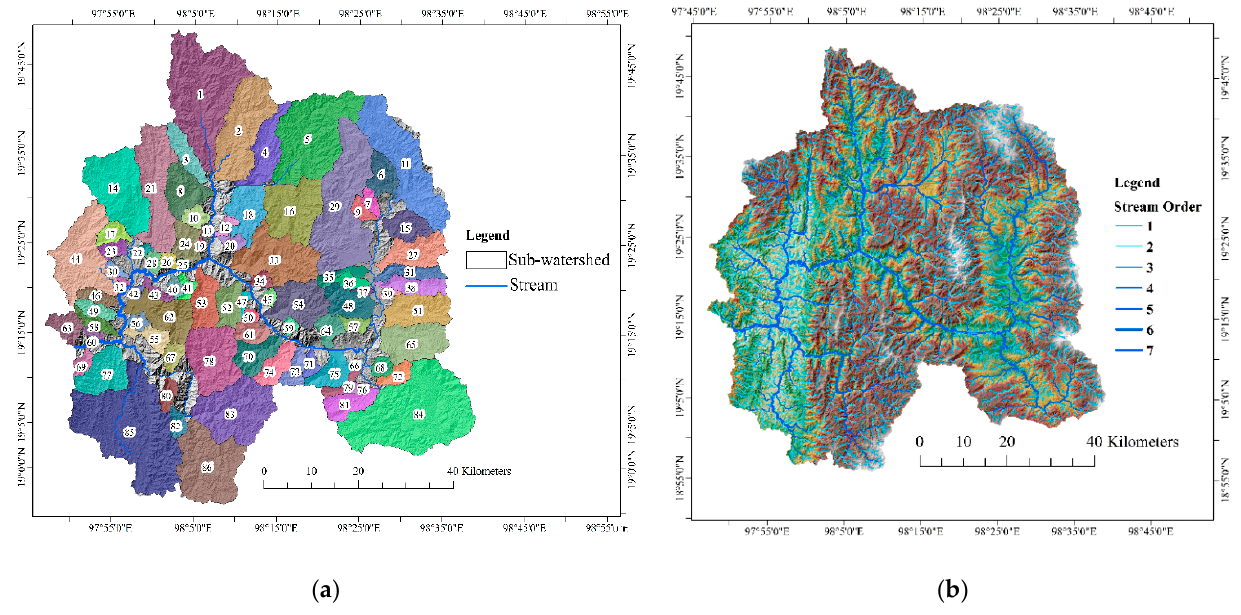
Figure 4. ( a ) Sub-watershed in the study; ( b ) Stream order in the